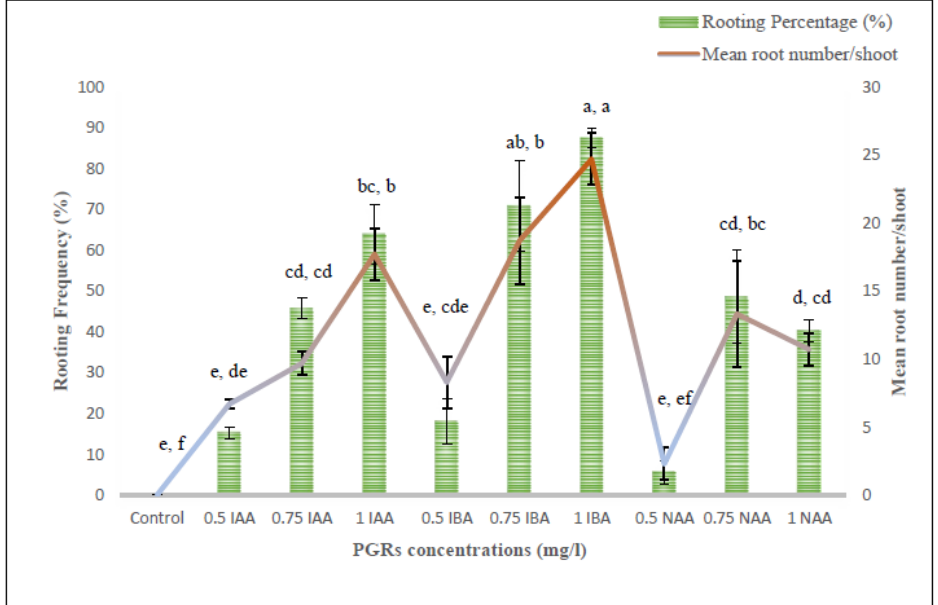
Figure 6. Effect of various PGRs concentration on root induction frequency and mean number of roots/shoot. Values indicate the mean ± SE of 3 replicates per treatment. Mean values with different superscripts within a column are significantly different from each other as per DMRT at p ≤ 0.05.